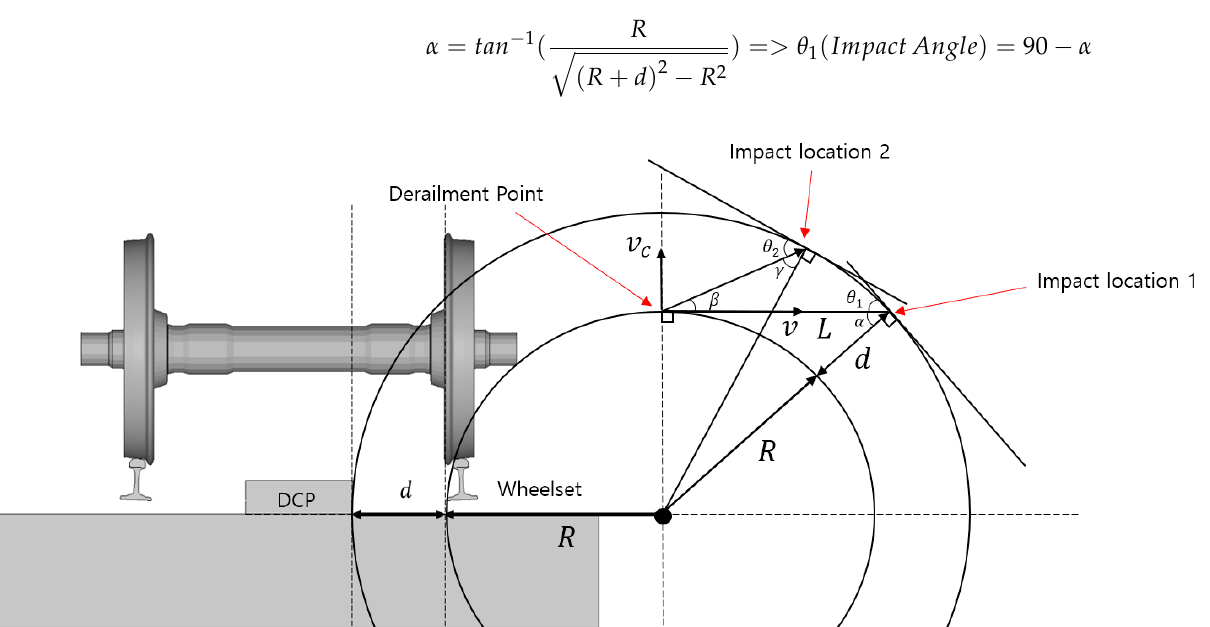
Table 1. Impact angle according to curve